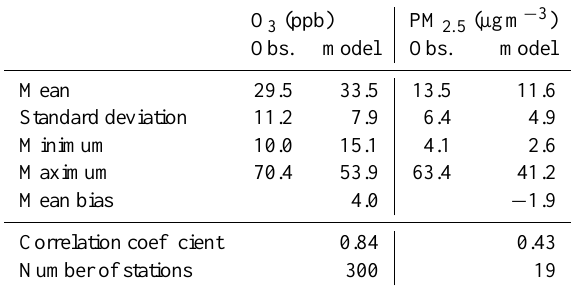
Table 2. Statistical quantities for O 3 and PM 2 . 5 using rural back- ground stations in the AirBase data set for 2006 (model output from the European domain).